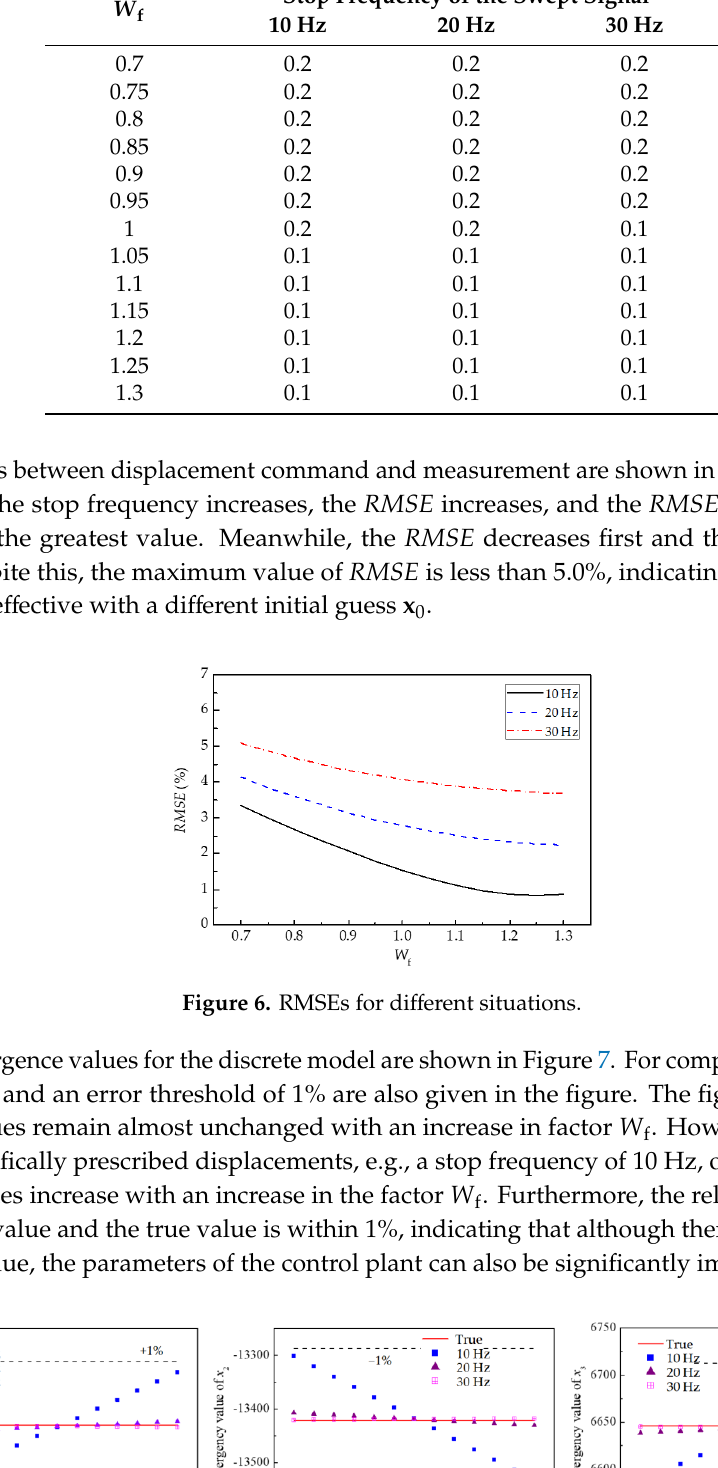
Table 4. Calculated time-delay.